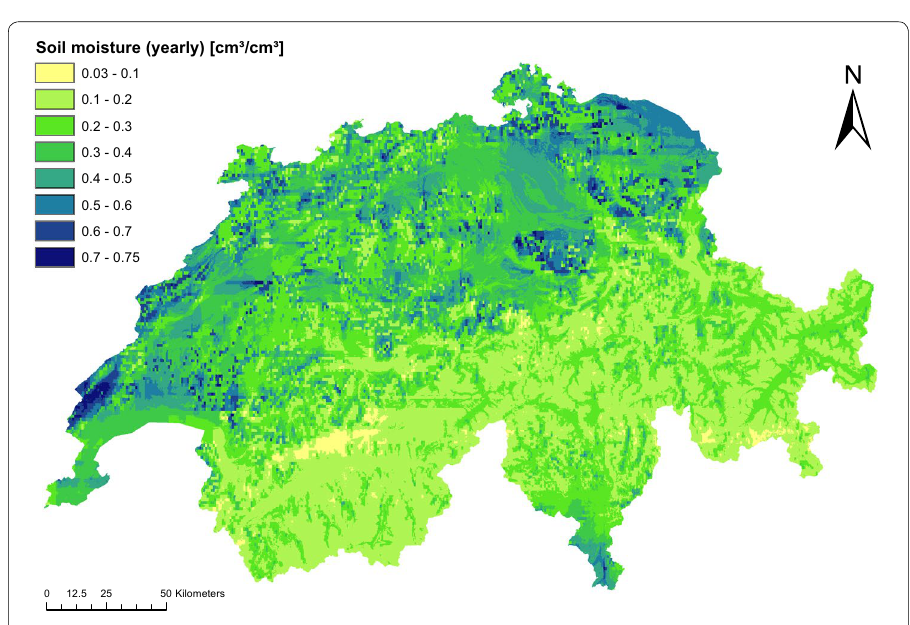
Fig. 2 Yearly soil moisture map estimated from the SMAP data in cm 3 /cm